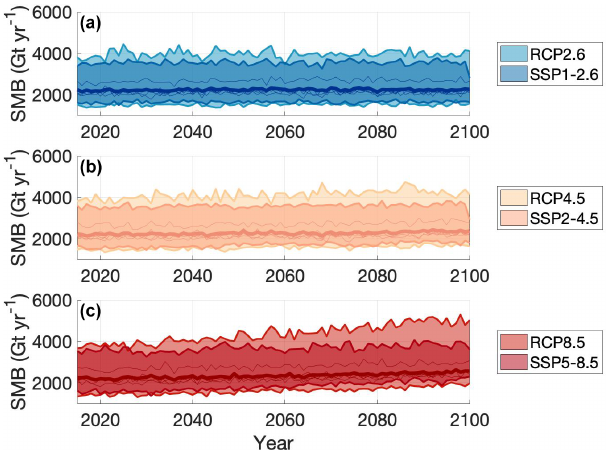
Figure 8. Time series for all CMIP5 (lighter colors) and CMIP6 models (darker colors) and best scoring models (skinny lines) and the best scoring models’ average (thick lines) for (a) RCP2.6 and SSP1-2.6 (blue), (b) RCP4.5 and SSP2-4.5 (yellow), and (c) RCP8.5 and SSP5-8.5 (red).